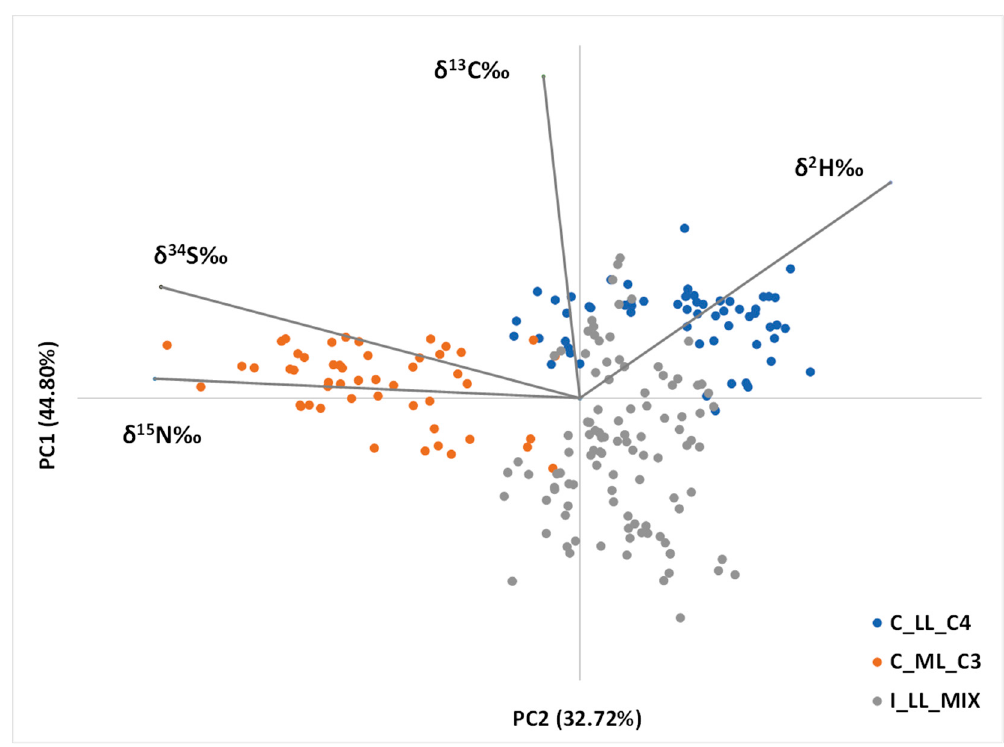
Figure 2. Plot showing the first two principal components (PC1 and PC2) determined from the analysis of beef protein δ ( 2 H), δ ( 13 C), δ ( 15 N), and δ ( 34 S) values. The three groups considered are identified by different colors: C_LL_C4 (animals from coastal areas, sited at relatively low latitudes, given a C4-based diet (Barcelona, Chalkidiki, Sicily, and Tuscany)) in blue; C_ML_C3 (animals from coastal areas sited at higher latitudes compared to the other groups, given a C3-based diet (Cornwall, Orkney and Bohernagore)) in orange; I_LL_MIX (animals coming from inland areas sited at relatively low latitudes, given a mixed diet (Limousin, Frankonia, Allgäu, Gäuboden, Mühlviertel, and Trentino)) in grey.